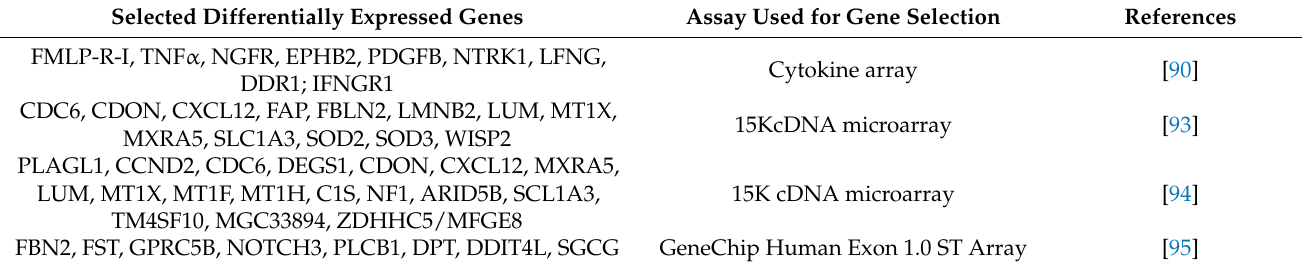
Table 3. Transcriptomic studies comparing skin fibroblasts from radiosensitive and radioresistant